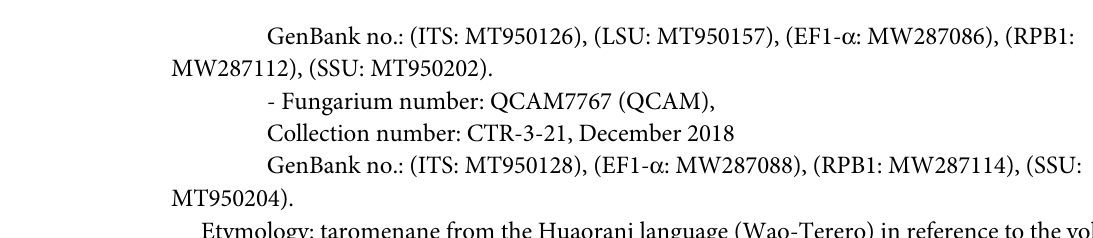
Fig 15. Basidiome and rhizomorphs of Polyporus taromenane . A. Basidiome and rhizomorphs on substrate A.1 Pore layer. B. Pileus. C. Stipe. D-F. Rhizomorphs. D. Fresh rhizomorph with white tip. E. Rhizomorphs with velvety appearance. F. Rhizomorphs attached to substrate and living plant material.